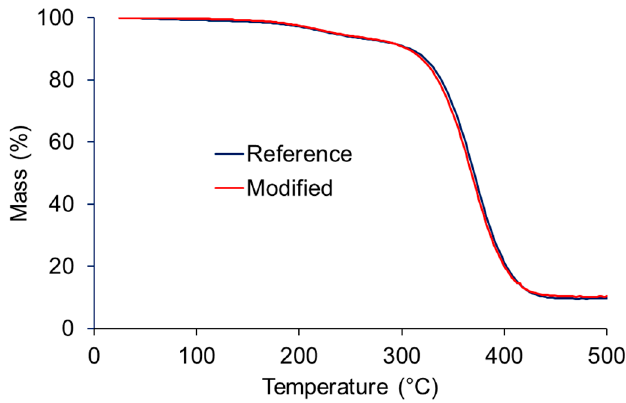
Figure 7. Results of the characterisation of sheets obtained from cured unsaturated polyester resin by means of thermogravimetric analysis (TGA).